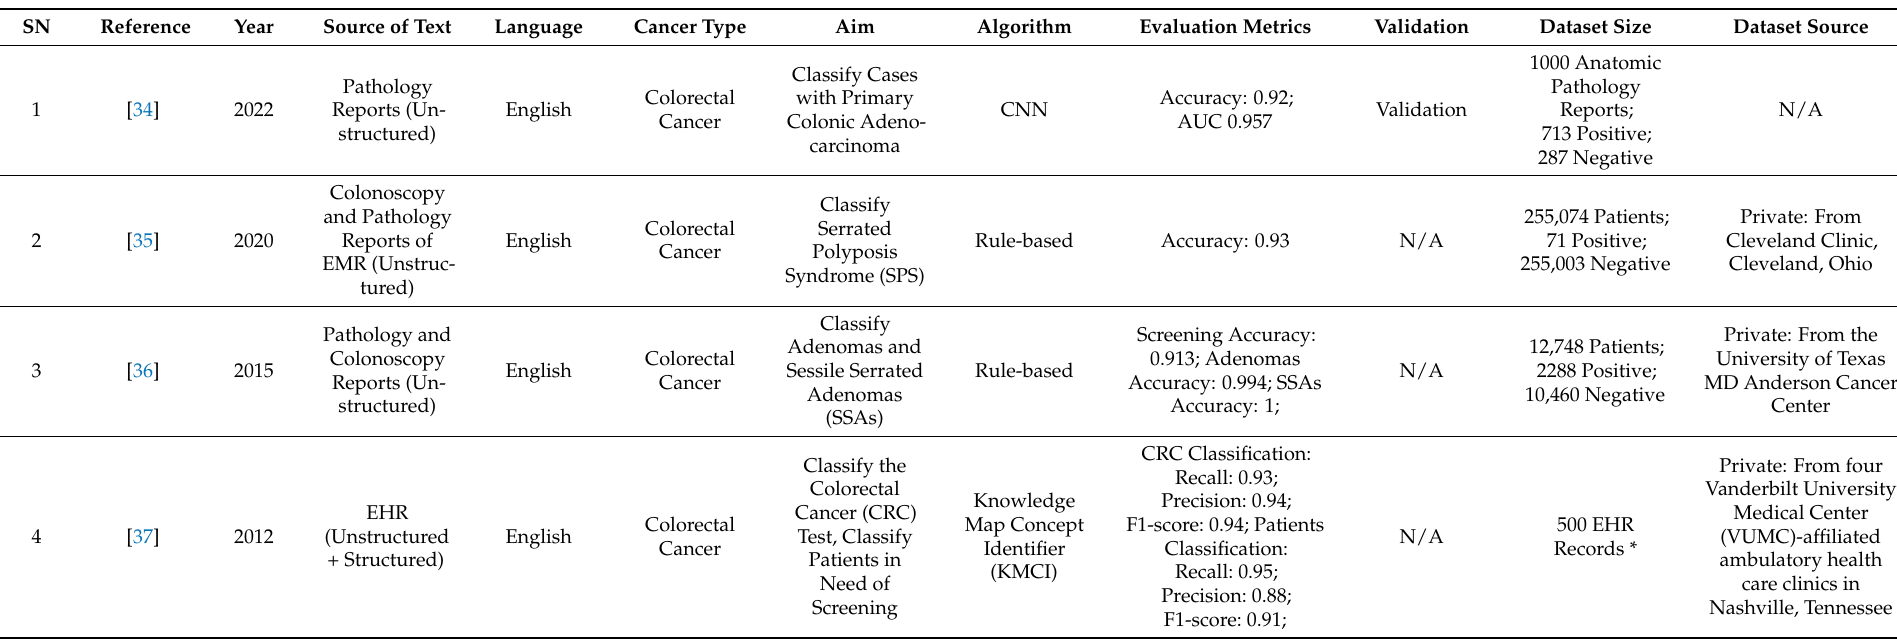
Table 4. Colorectal cancer-related studies. * represents that we only show the size of the dataset because the dataset has too many types of data (more than three), the distribution of the dataset is not fully described, or it is not easy to show the structure of the dataset for other